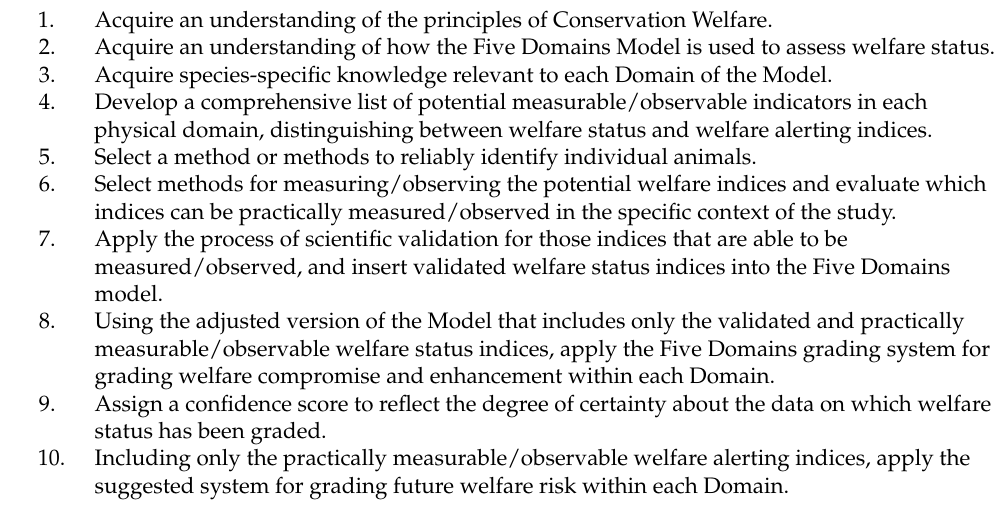
Table 1. The Ten-Stage Protocol (from Harvey et al., 2020 [4]).